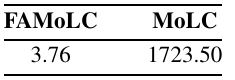
Table 3. Computational time for parameter estimation for both methods, in seconds, applied to the real images in Fig. 4